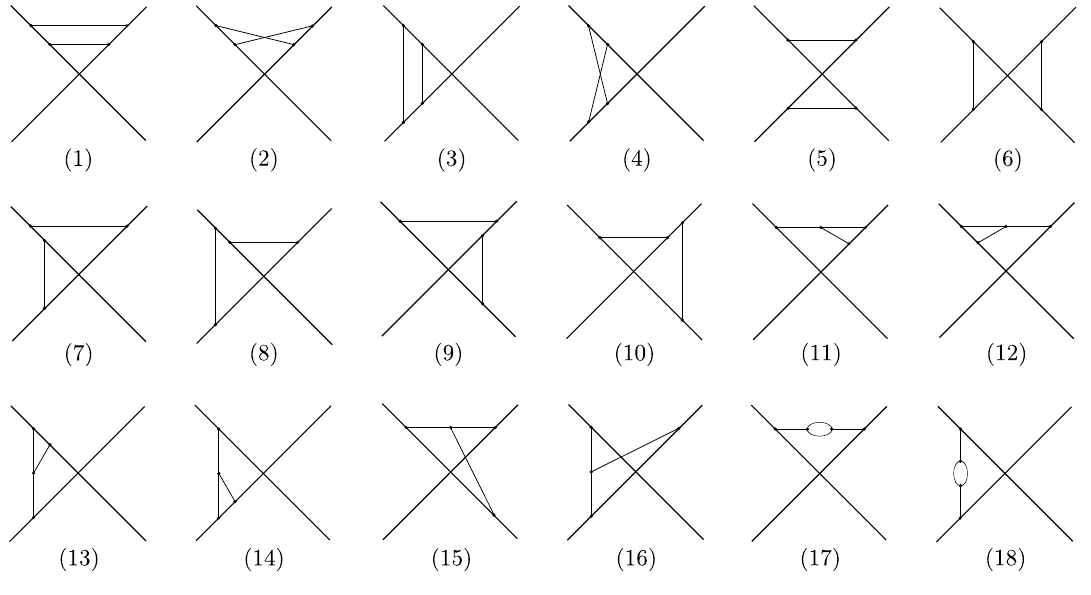
Figure 7 . All diagrams at the two-loop